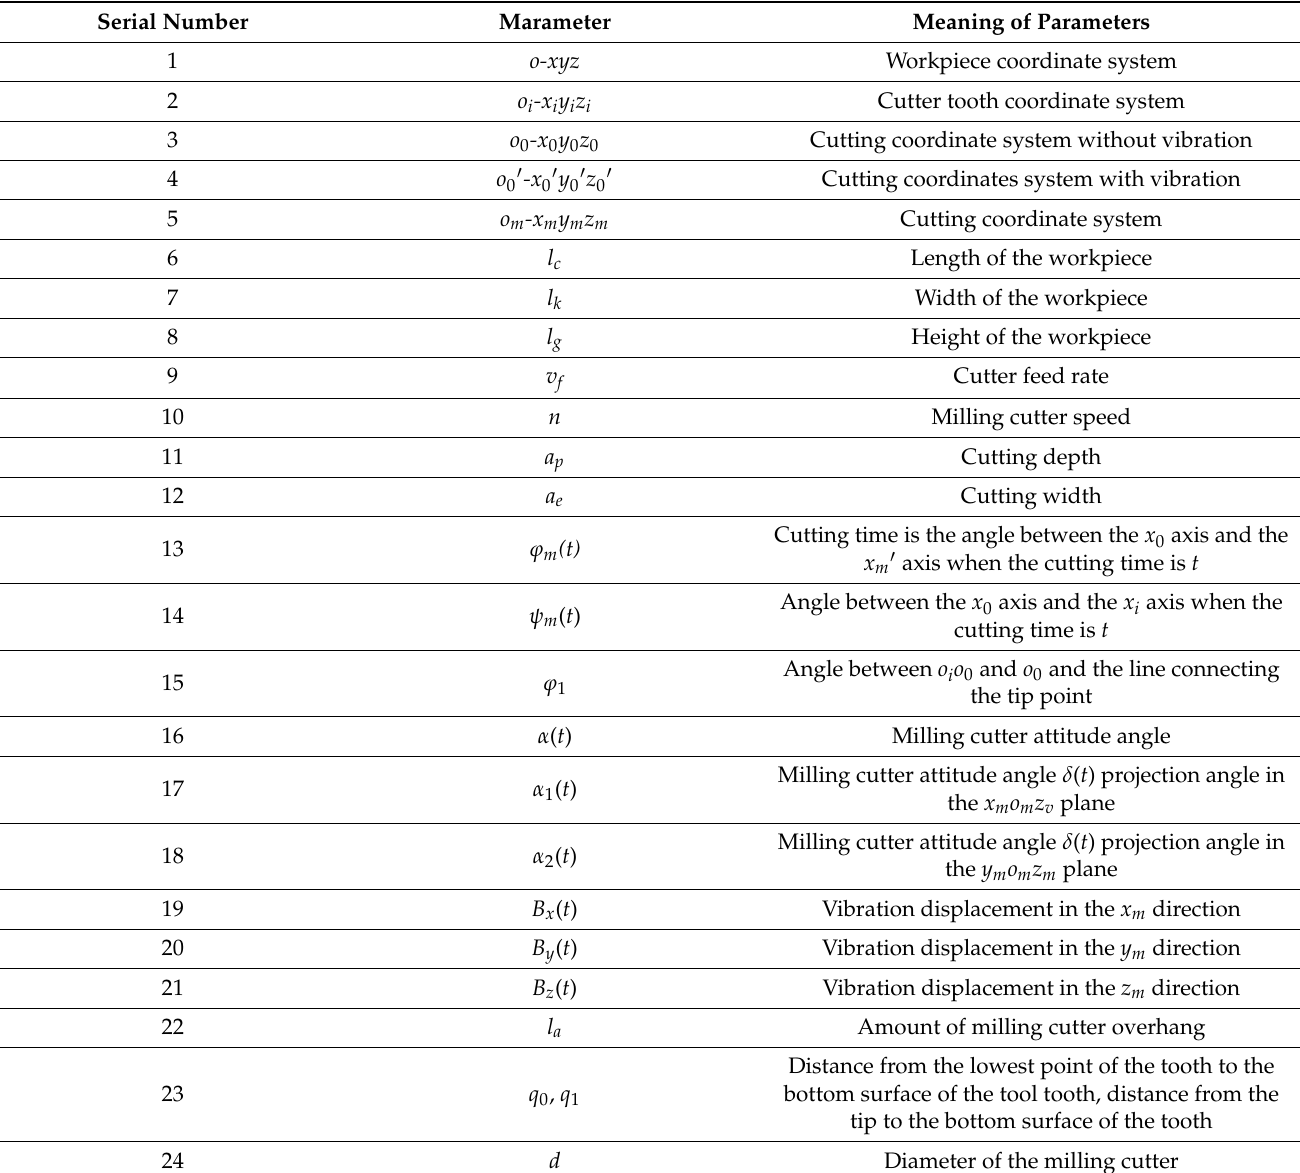
Table 1. Illustration of instantaneous milling process variables of high-feed milling cutter under